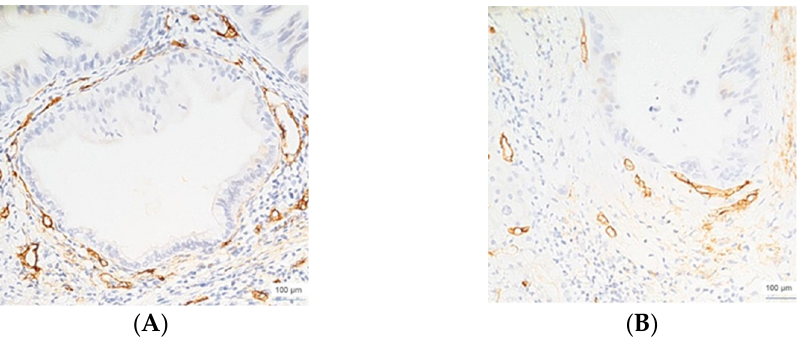
Figure 2. CD34 immunoexpression in moderately differentiated colon adenocarcinoma, ×200 magnification ( A ), and corresponding liver metastasis, replacement HGP, ×100 magnification (B ). All colorectal adenocarcinomas that developed LM with a d-HGP, had a value 2 for the score (Figure 3), except for one case, assessed with a score of 3. CLIC1 expression was heterogeneous in intensity, distribution, and pattern. Thus, cytoplasmic, cytoplas- mic/membranous, nuclear and nuclear/cytoplasmic expression were noticed. Most of the LM with a d-HGP (66.66%) had a value of 3 for the CLIC1 score (eight cases). Four cases were quantified with a score of 2. The same expression pattern was found in LM. The vessels’ endothelium of the connective ring, from the periphery of the metastatic area, also expressed CLIC1.